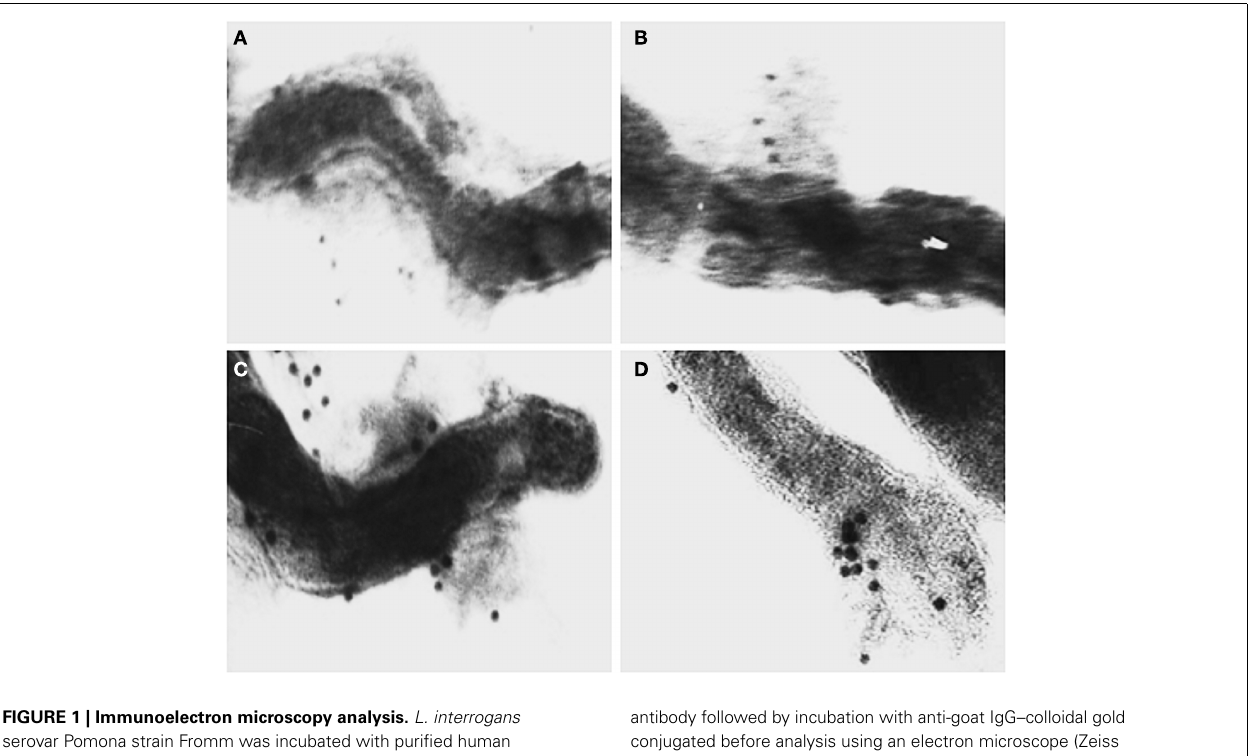
FIGURE 1 | Immunoelectron microscopy analysis. L. interrogans serovar Pomona strain Fromm was incubated with purified human FH His 402 (A,B) or FHTyr 402 (C,D) . After extensive washing, leptospires were incubated with goat anti-human FH